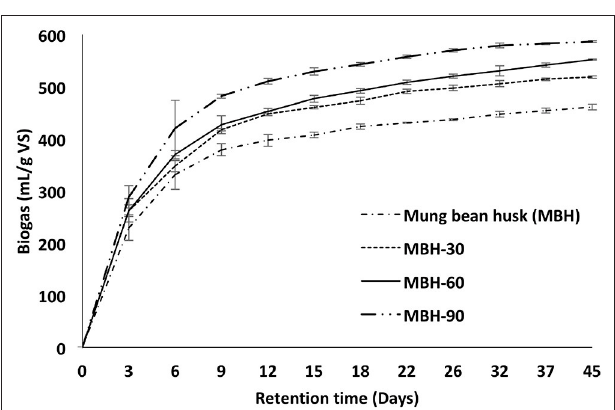
FIGURE 10 | Accumulated biogas and Methane yield from pretreated MBH.